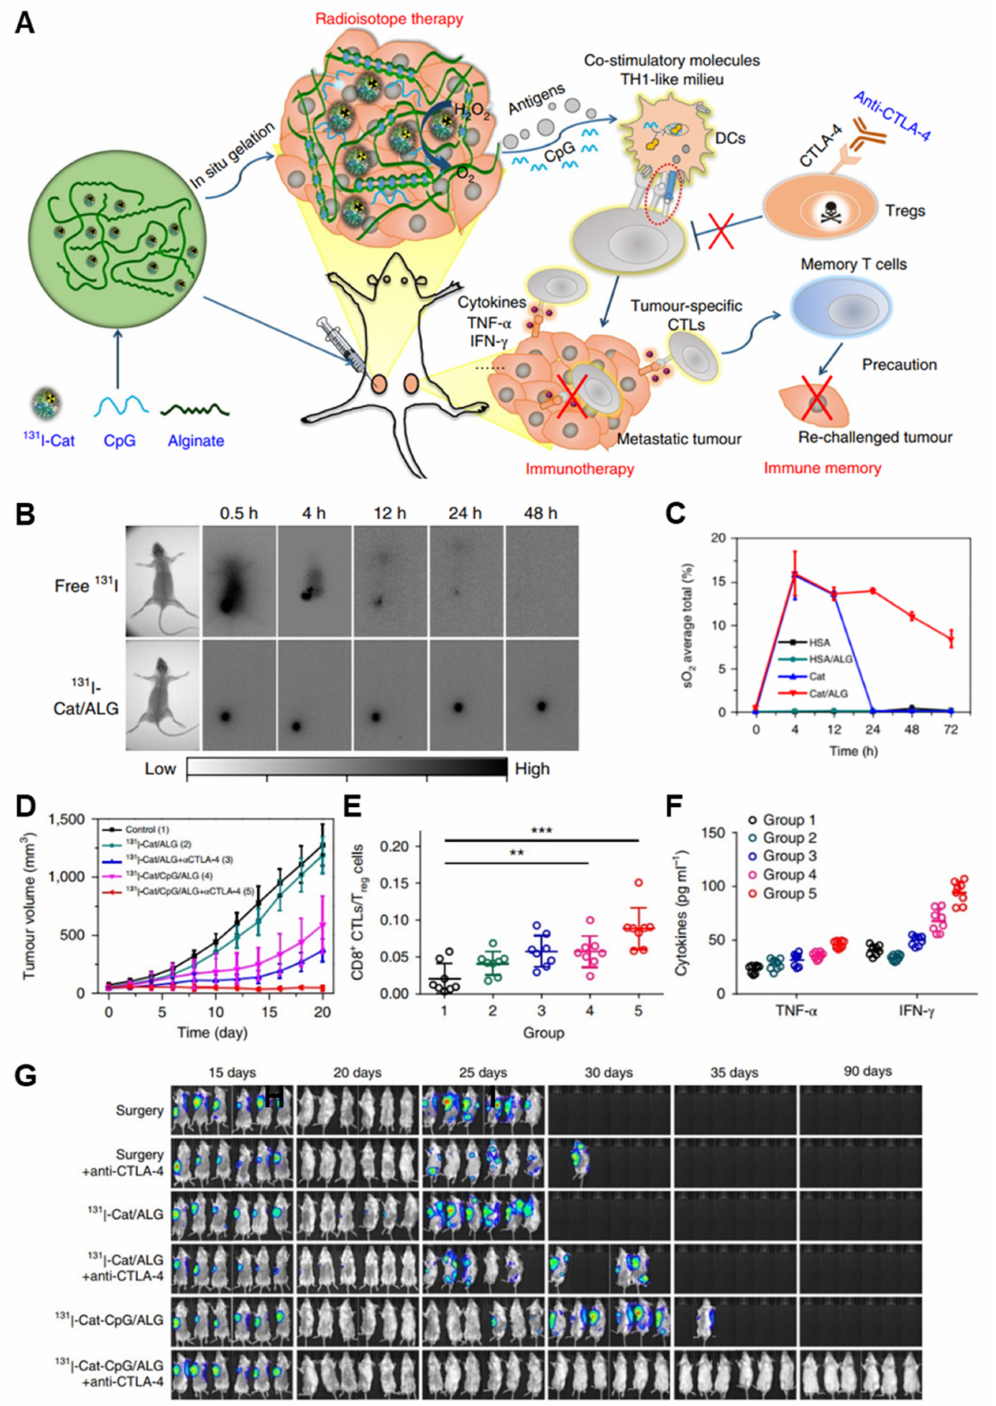
Figure 5. Injectable hybrid hydrogel with 131 I radioisotope and CpG for combination radioim- munotherapy. ( A ) Schematic illustration of the mechanism of ICB-combined 131 I- and CpG-loaded hydrogel eliciting antitumor immune responses. ( B ) Gamma scintigraphy whole-body images of 131 I in 4T1 tumor-bearing mice. ( C ) Quantification of levels of the average total sO 2 in tumors after treatments. ( D ) Tumor growth curves of primary tumors after treatments. ( E ) CD8 + CTL to T reg ratios in secondary tumors. ( F ) Quantification of the amounts of TNF- α and IFN- γ in sera after treatments. ( G ) Visualized bioluminescence image of the implanted FLuc-4T1 tumors representing metastases after treatments. ** p < 0.01, *** p < 0.001, one-way ANOVA for indicated comparison. Figures are reproduced from [52], with permission from Springer